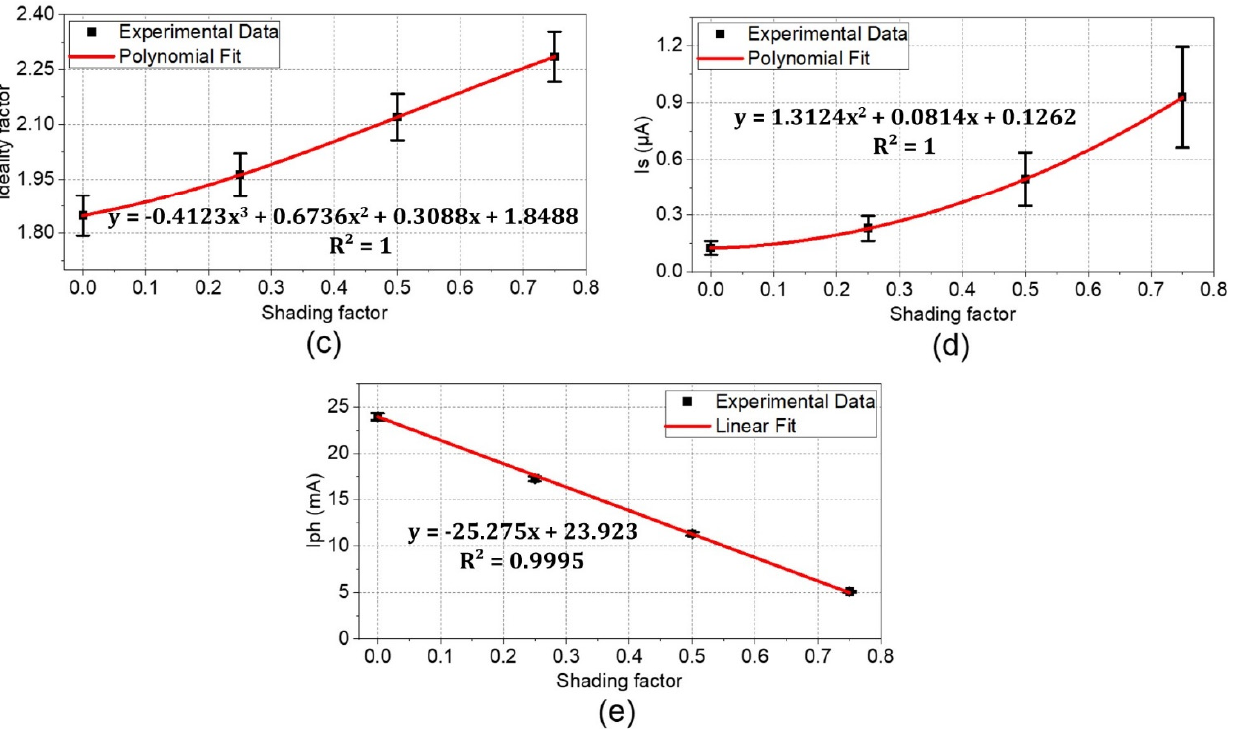
Figure 5. The variation of the equivalent circuit parameters with shading: ( a ) Series resistance; ( b ) Shunt resistance; ( c ) Ideality factor; ( d ) Reverse saturation current; ( e ) Photo-generated current. Each data point in the figures represents the average value of the data extracted from two I-V curves with each I-V curve formed using the average of three measurements. The error bars were determined from 12 measurements taken without shading in STCs.